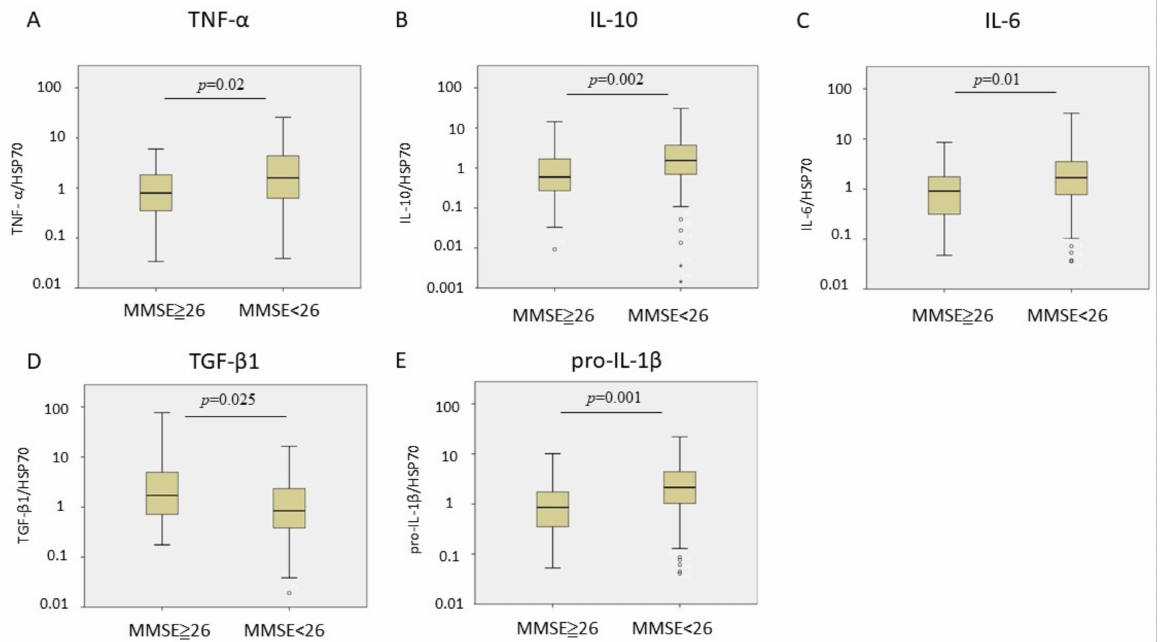
Figure 2. Cytokine levels in plasma extracellular vesicles for Parkinson’s disease with Mini-Mental State Examination (MMSE) less than 26 ( n = 51) and equal/above 26 ( n = 62). ( A – E ) Comparison of tumor necrosis factor (TNF)- α , interleukin (IL)-10, IL-6, transforming growth factor (TGF)- β 1, and pro-IL-1 β levels between PD patients with MMSE less than 26 and equal/above 26. Heat shock protein (HSP)-70 was the protein loading control. The box-and-whisker plot was presented as median, 1st quartile and 3rd quartile of the box, the 95th and 5th percentile for the upper and lower whisker, for the